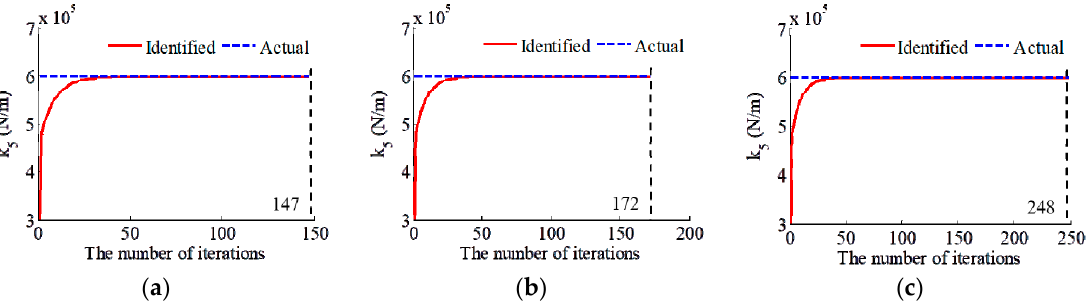
Figure 3. Comparison of the effect of noise intensity on the iteration process: ( a ) noise-free; ( b ) 5% noise; ( c ) 10% noise.